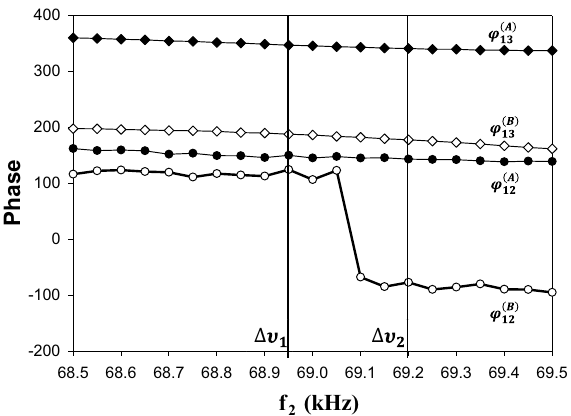
Figure 8. Phases ϕ 12 (open symbols) and ϕ 13 (closed symbols) measured for the phi-bits A and B as functions 70kHz �υ where �υ is a frequency tuning parameter. A change of tuning parameter from �υ 1 to of f 2 = − �υ 2 corresponds to the action of a two phi-bit CNOT-like gate. See text for details. The frequencies are in kHz and the phase in